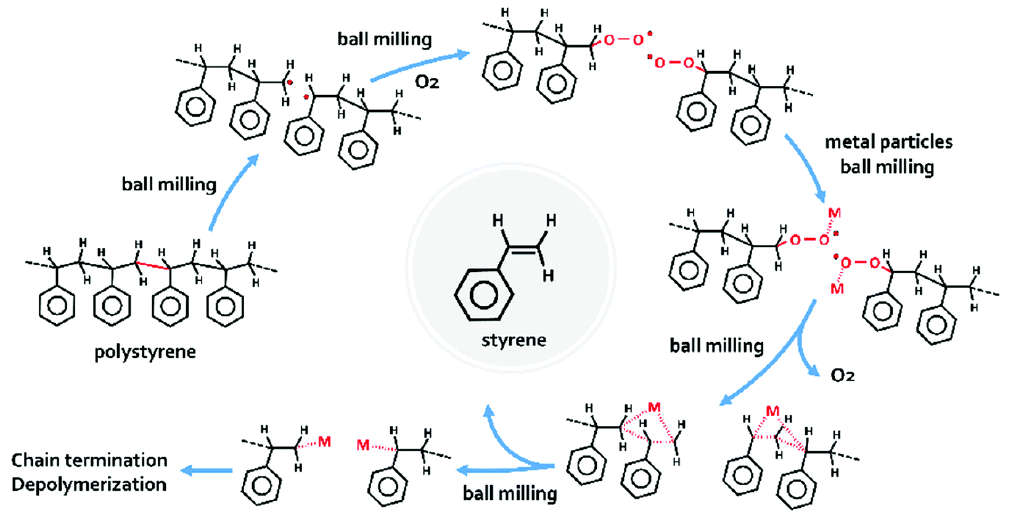
Figure 18. ( a ) Nanohardness and ( b ) elastic modulus under indentation loads of 20, 50, and 100 mN for Fe 2 O 3 nanocomposites, ZnO nanocomposites, and recycled EPS composite. Reprinted with permission from ref. [51].